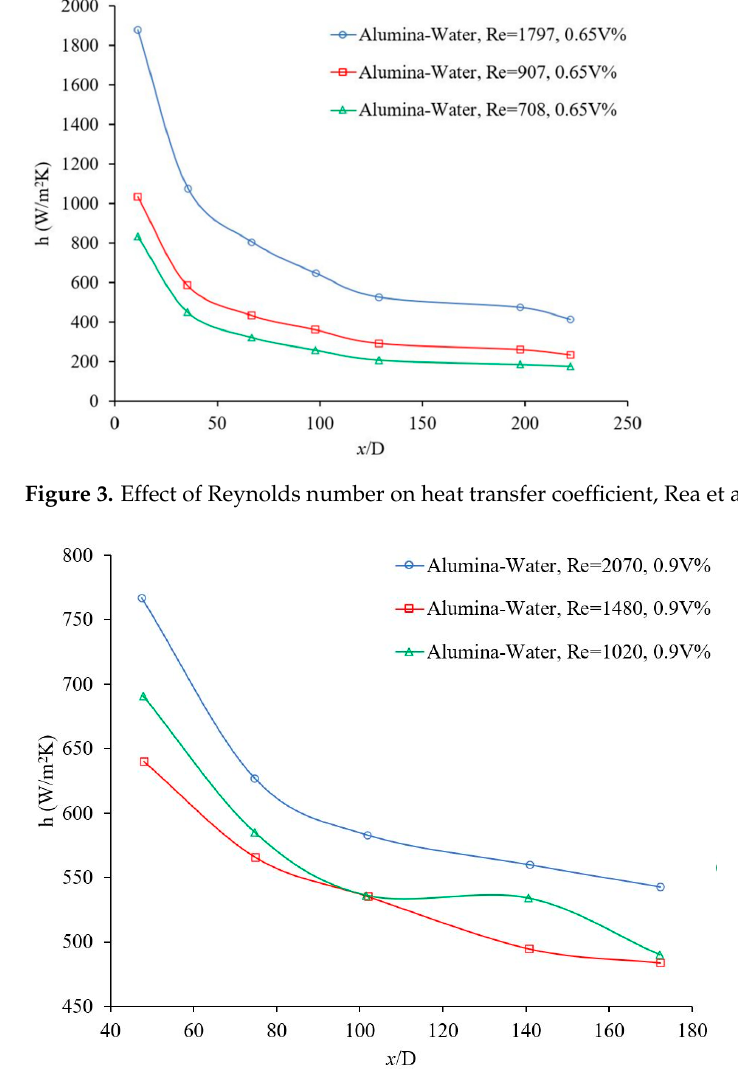
Figure 5. Effect of Reynolds number on heat transfer coefficient, mass concentration 9 wt %, Haghighi et al. [28].